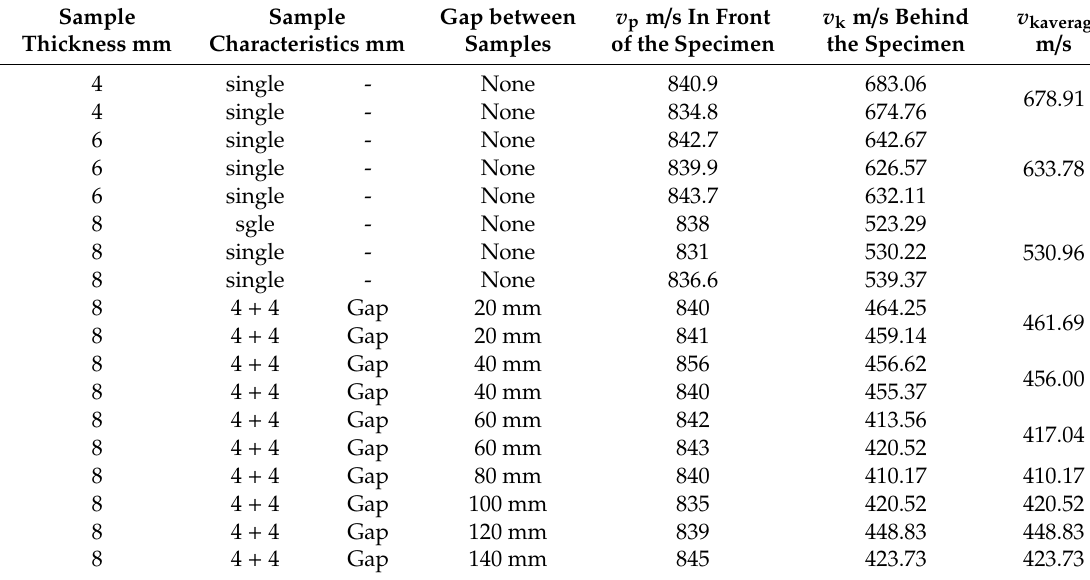
Table 2. Test results for 1.3964 steel.